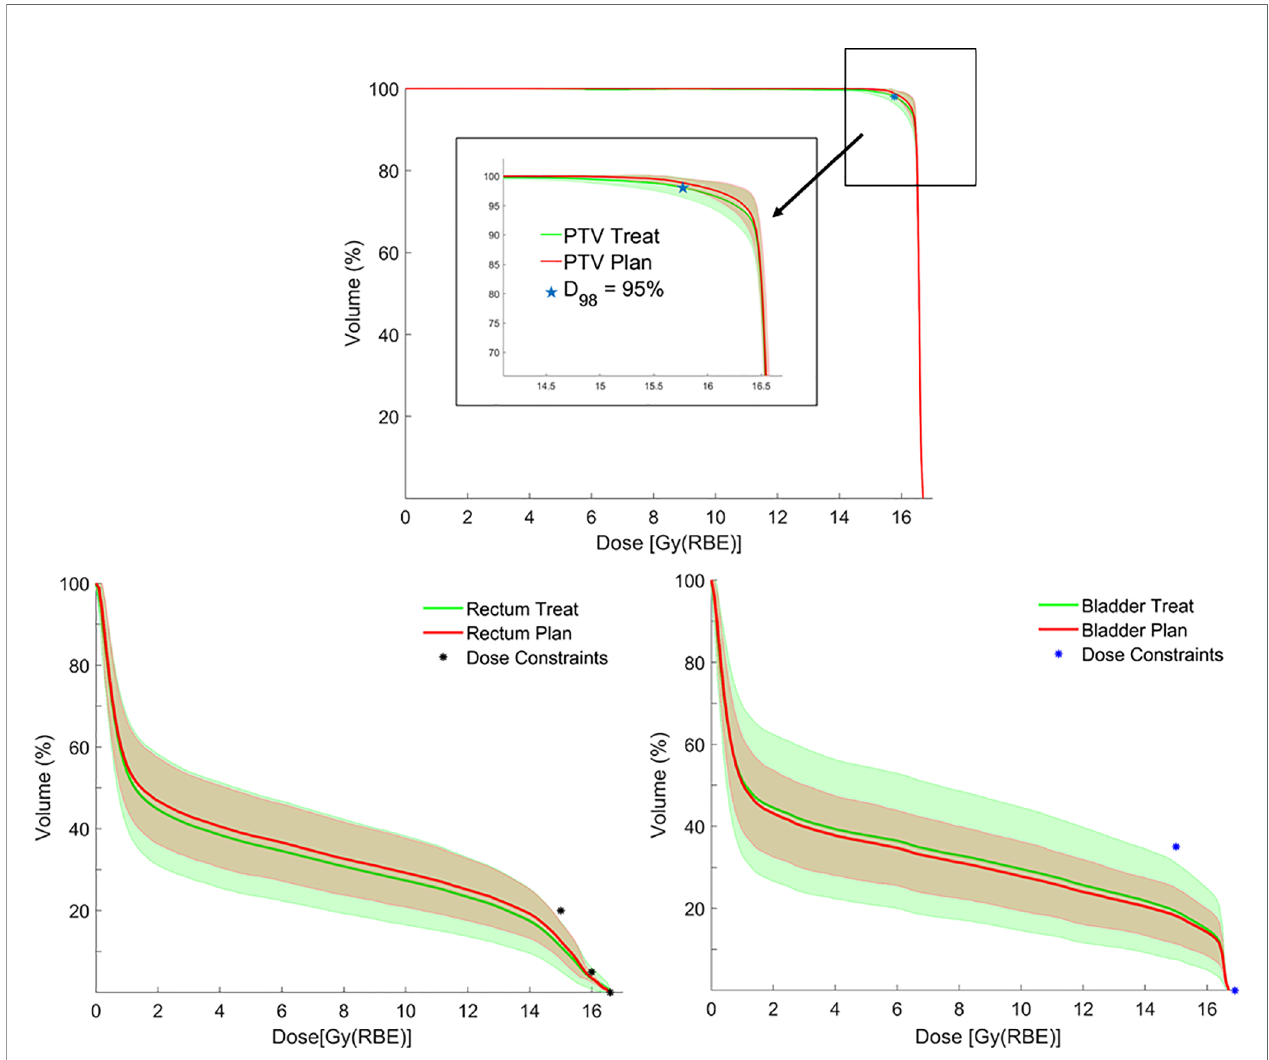
FIGURE 4 | Average dose – volume histograms (DVHs) for planning target volume (PTV), rectum and bladder calculated on planning CTs (pCTs) (red lines), and synthetic CTs (sCTs) (green lines), with corresponding error bands (± 1 standard deviation) together with bladder/rectum dose constraints and PTV coverage